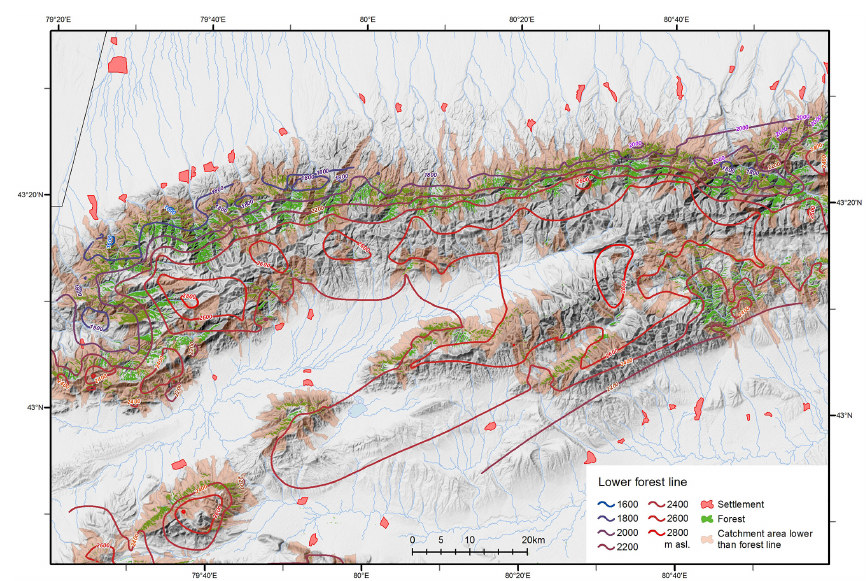
Figure 6. The lower forest line and the catchment areas providing lower forest line values in the investigation area.